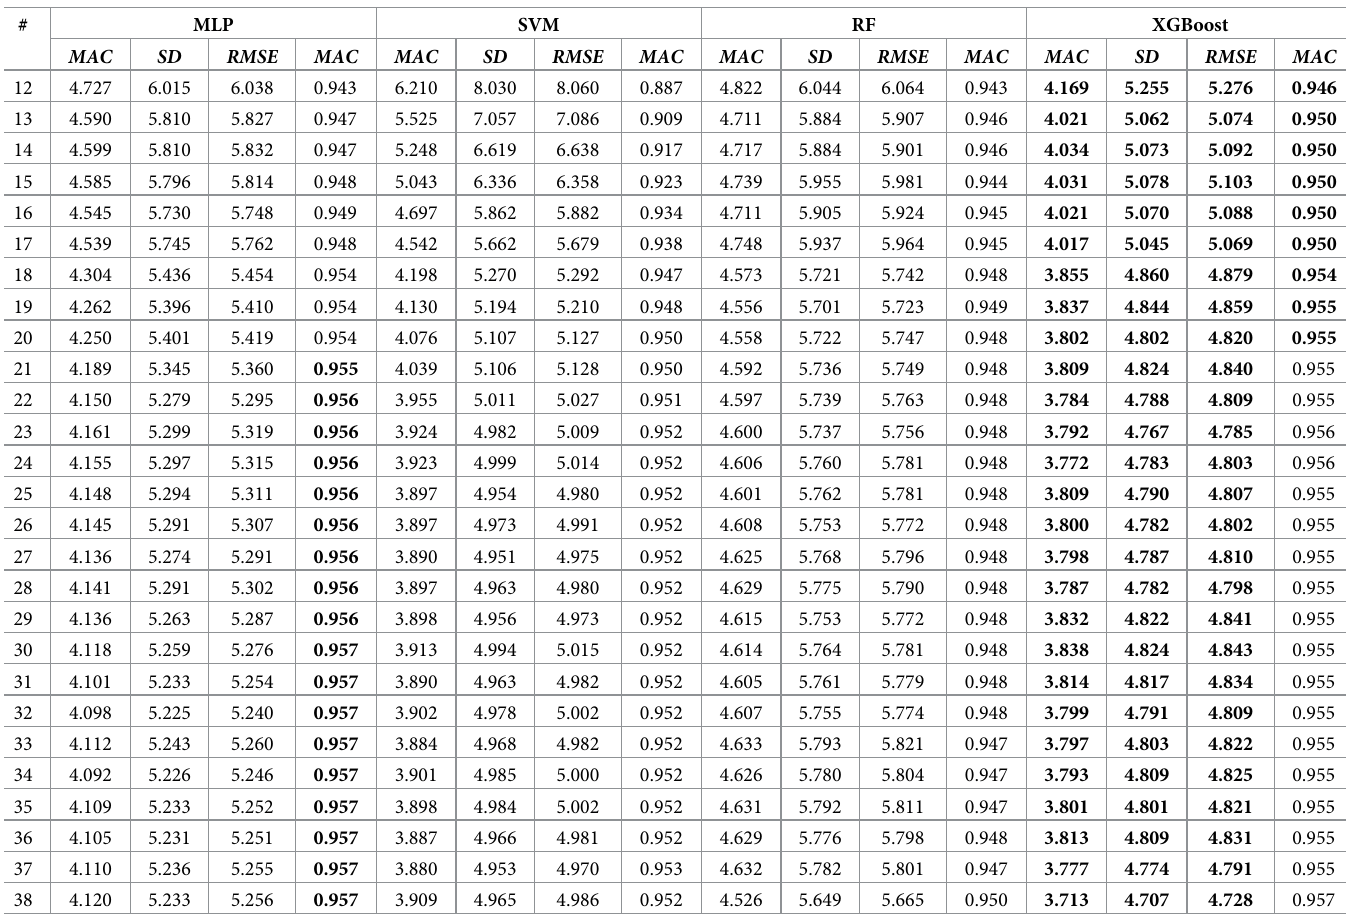
Table 11. Experimental results for the MLP, SVM, RF, and XGBoost, based on the NHANES dataset, with FA feature extraction (best results are highlighted in bold; # means the number of